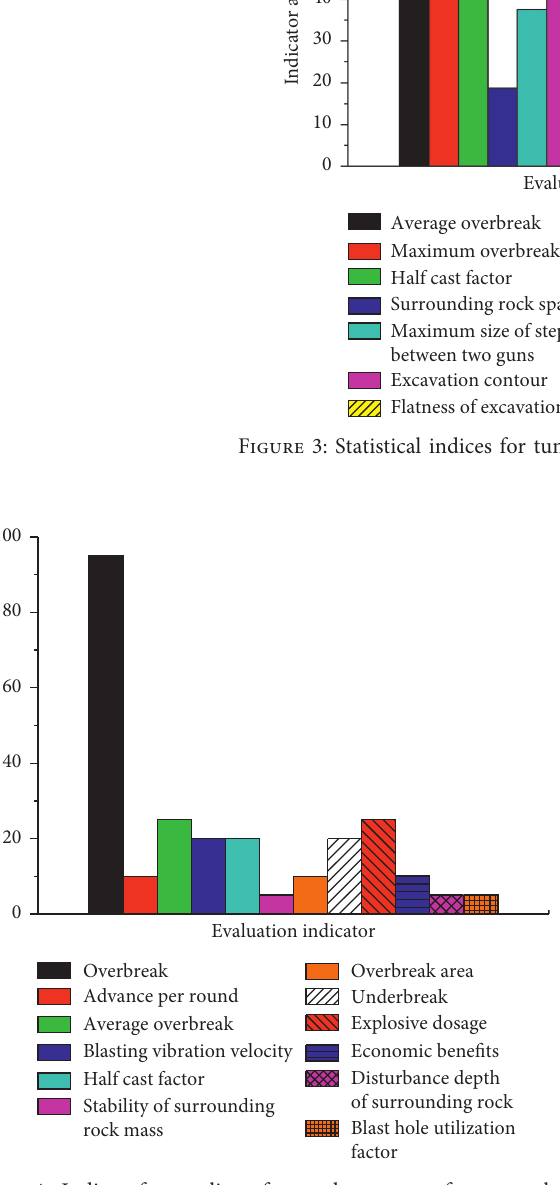
Figure 4: Indices for quality of tunnel contour after smooth blasting in overseas countries.